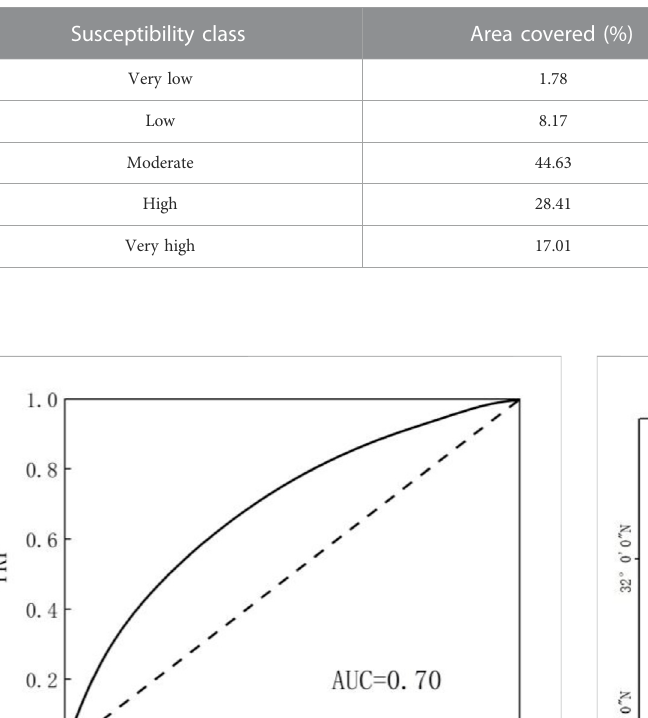
TABLE 7 Statistics of landslide susceptibility in the study